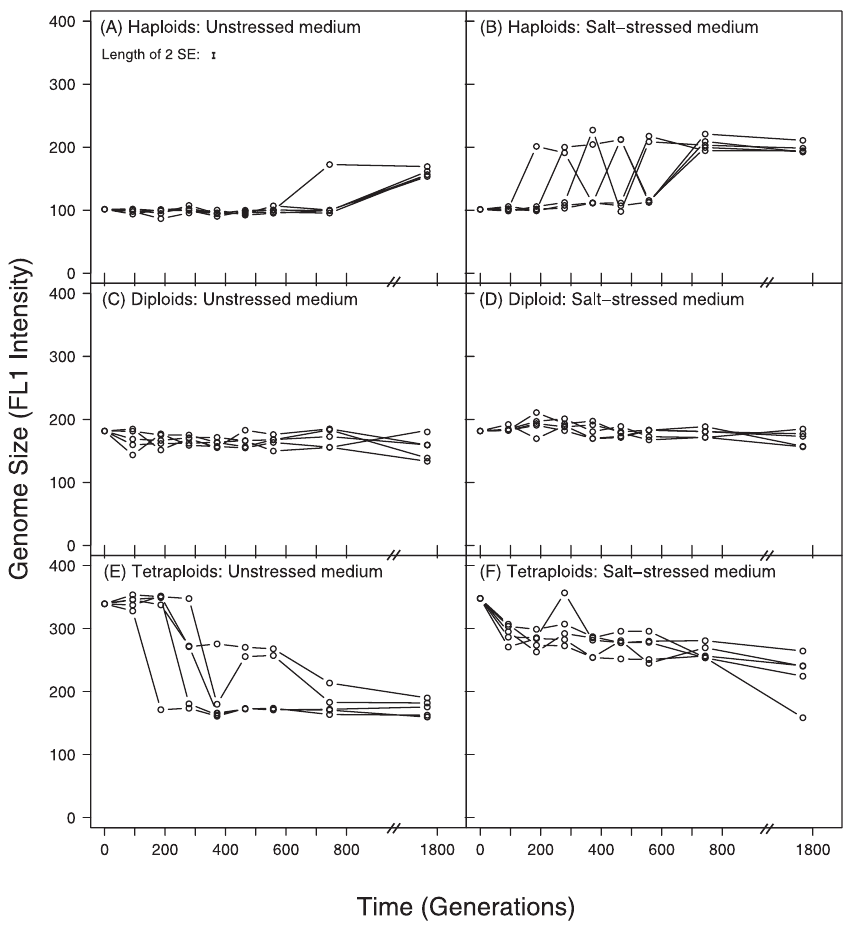
Figure 1. A Snapshot of Genome Size Change across 1,766 Generations of Batch Culture Evolution Each data point is the mean of three FACScan measurements on a single colony sampled from a population. Apparent fluctuations are largely a result of genome size polymorphisms, leading to sampling fluctuations depending on which colony was randomly chosen (see Figure S1). The average standard error (shown in panel A) reflects measurement error. FL1 represents a linear scale of dye fluorescence as measured by flow cytometry. The five lines on each graph represent the five replicate lines evolved